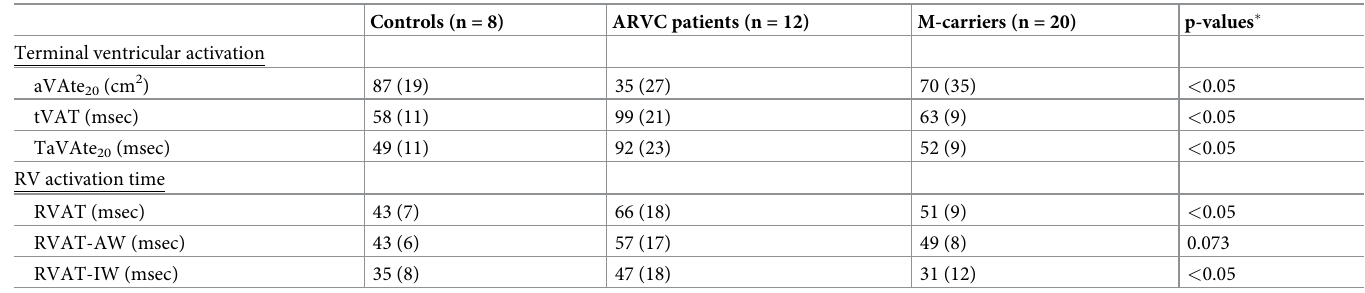
Table 2. Characteristics of epicardial ventricular activation.